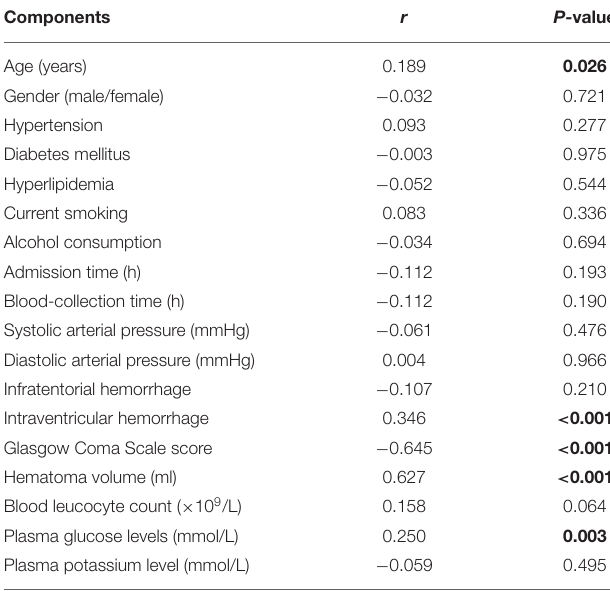
TABLE 2 | Correlations between plasma cellular prion protein levels and other variables using univariate linear regression analysis in intracerebral hemorrhage. Components